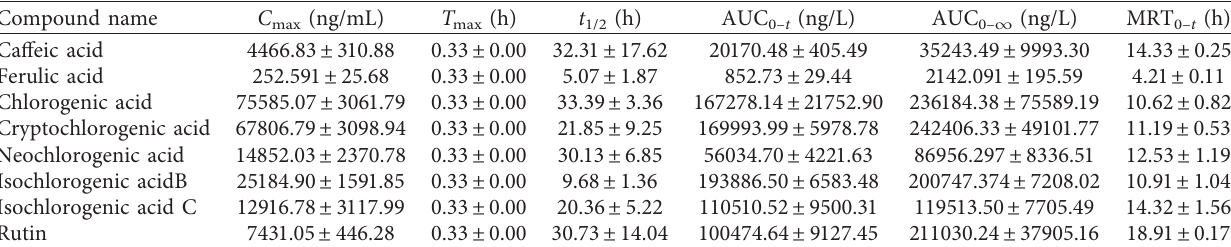
Figure 3: Mean plasma concentration time curves of caffeic acid (a) ferulic acid, (b) chlorogenic acid, (c) cryptochlorogenic acid, (d) neochlorogenic acid, (e) isochlorogenic acid B, (f) isochlorogenic acid C, and (g) rutin, (h) after oral administration of R-FF and H-FF extracts. Table 6: Pharmacokinetic parameters of the 8 compounds in rats after oral administration of R-FF extracts (mean ± SD, n �